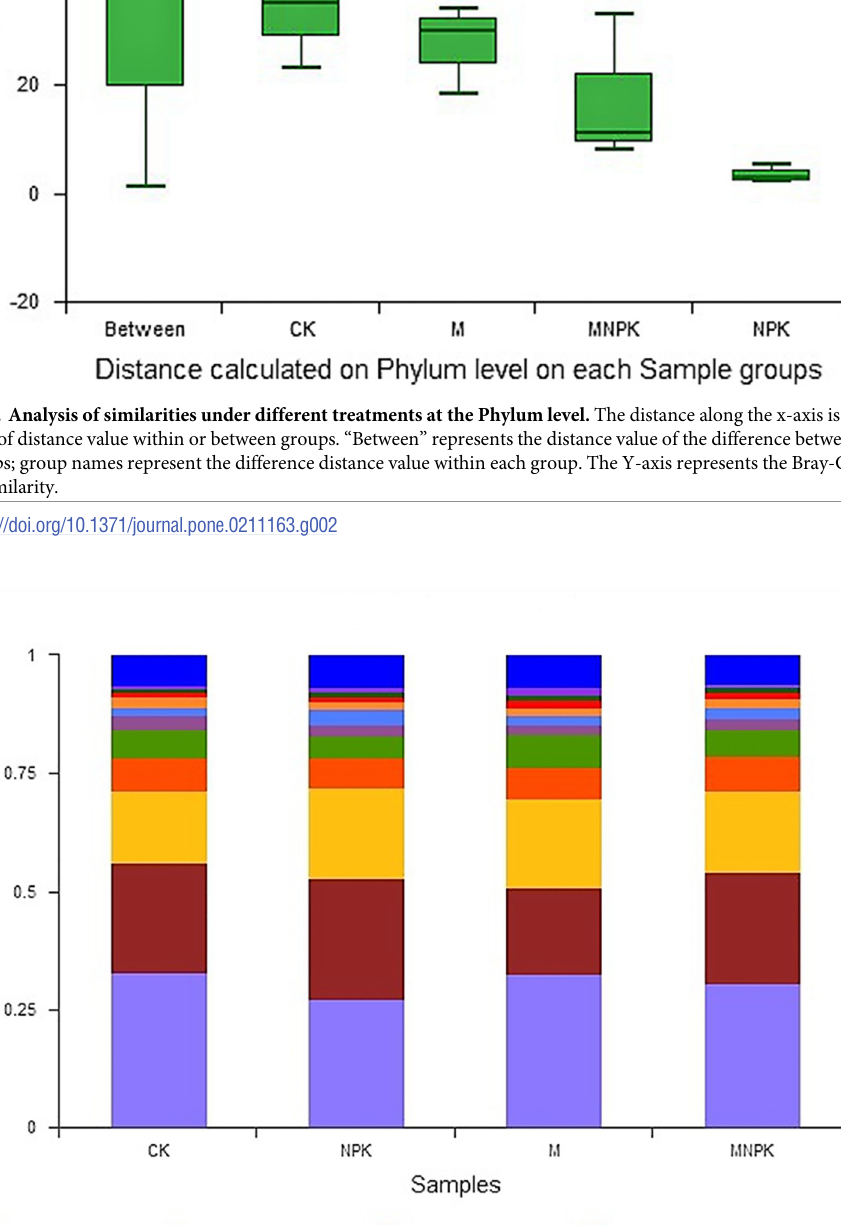
PLOS ONE | https://doi.org/10.1371/journal.pone.0211163 January 25,